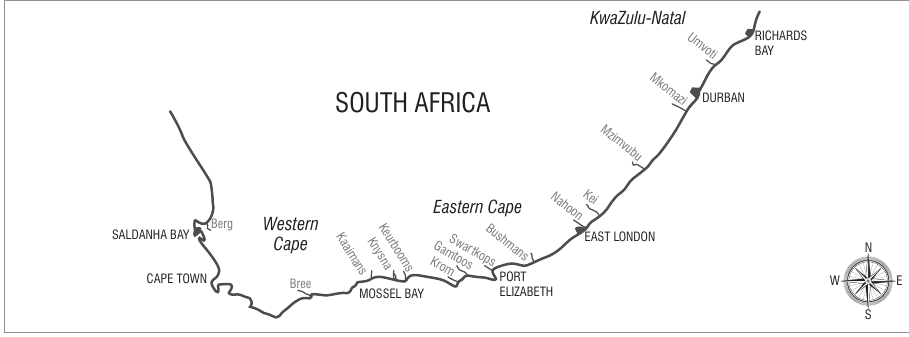
Figure 1: Map of South Africa depicting the positions of the various ports and estuaries discussed in the